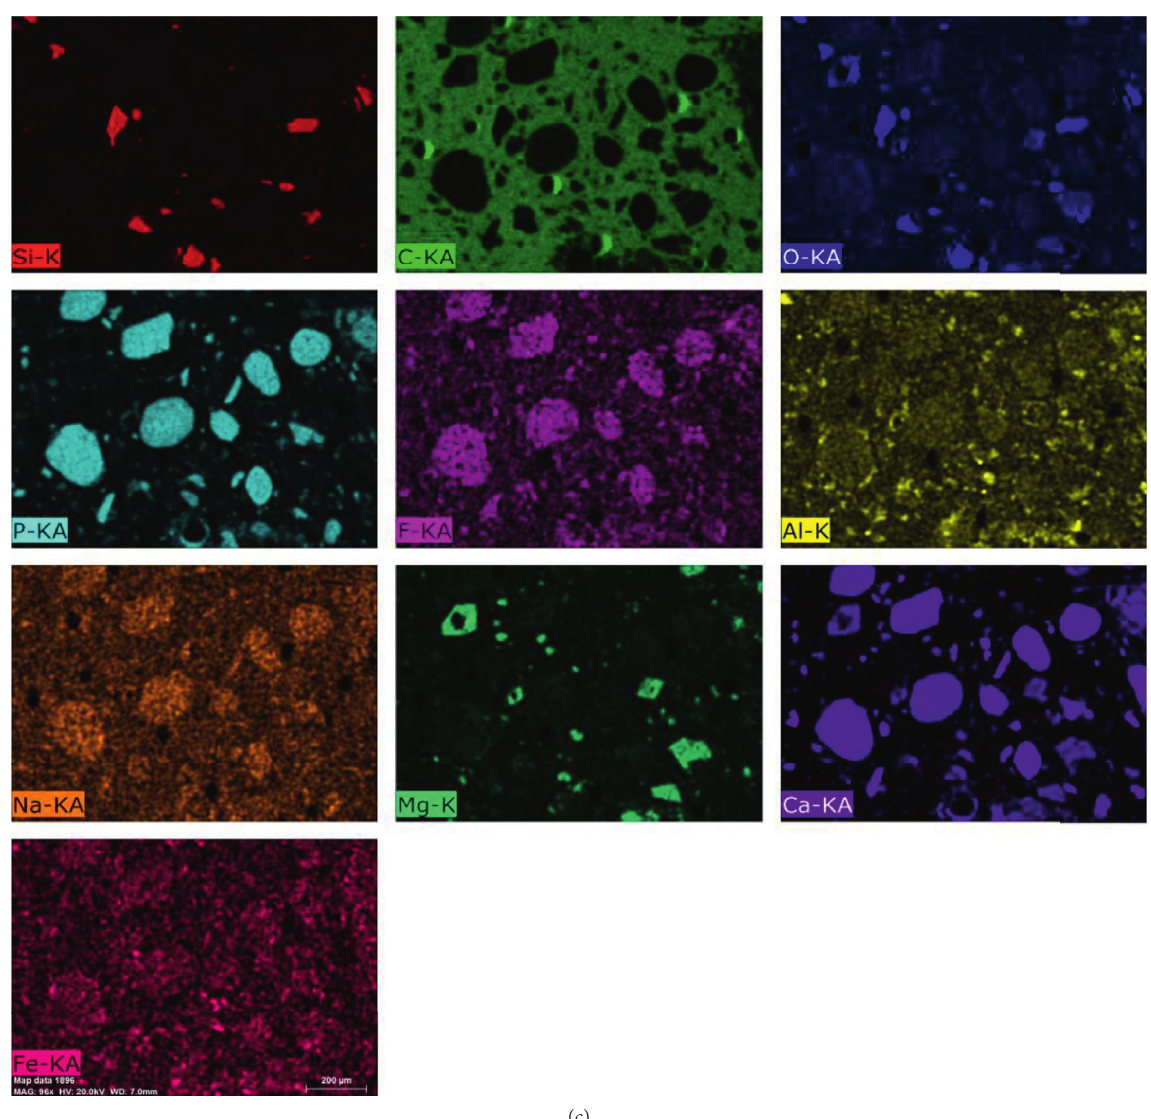
Figure 16: Backscattered electron diagram and element distribution diagram of collophane, calcite, and quartz. (a) Backscattered electron image. (b) Backscattered element diagram. (c) Regional element distribution